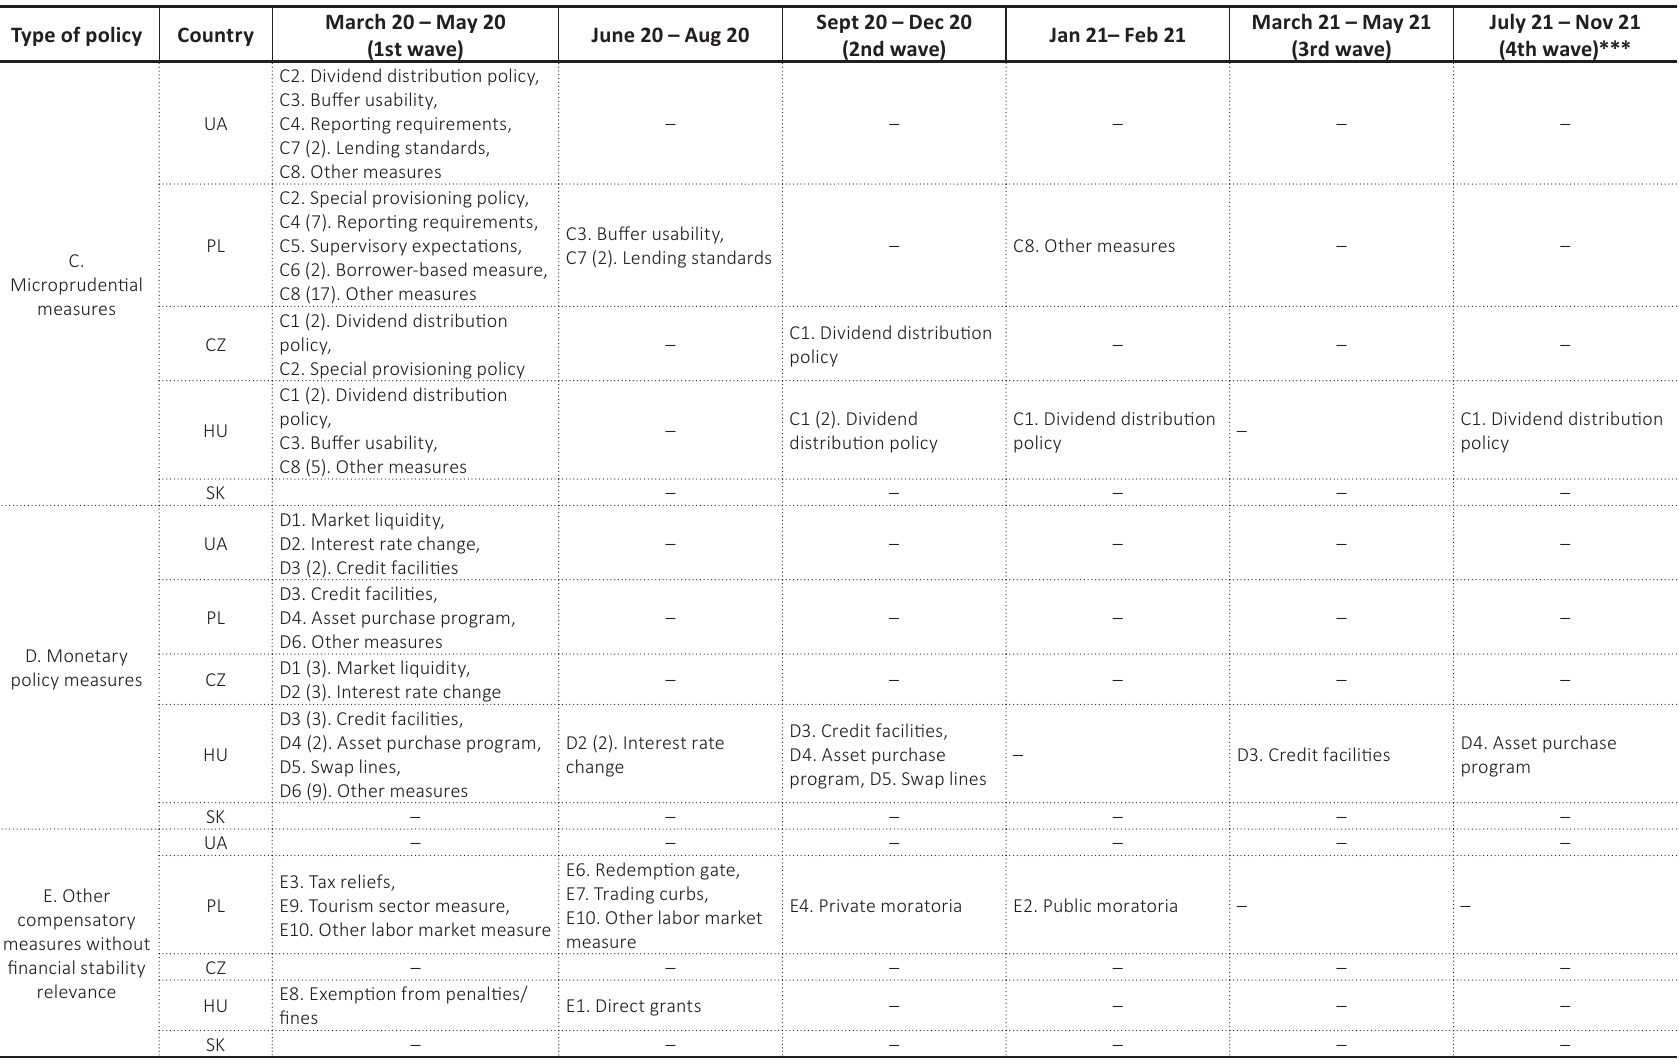
Table 4 (cont.). Compensatory measures for Ukraine and Visegrad Group countries classified according to the type of policy and systematized by the periodization of the COVID-19